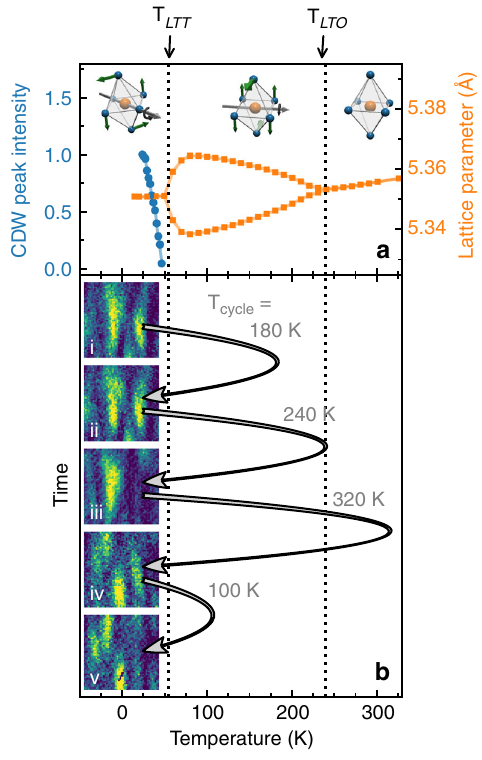
Fig. 3 CDW and structural phases in LBCO 1/8 compared to speckle memory. a Temperature dependence of normalized CDW peak intensity (blue) and lattice parameters reproduced from ref. 49 (orange). The CDW transition coincides with the LTT structural transition at T LTT . A second lattice transition occurs at T LTO . The inset images represent the octahedral tilts associated with the LTT, LTO, and HTT phases. b CDW speckle images taken at 24 K. The black arrows indicate the temperature cycling between images. T cycle indicates the highest temperature that sample was brought to during a temperature